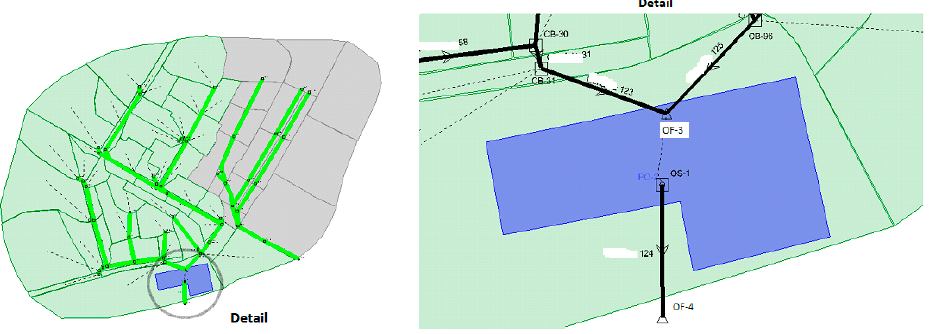
Figure 6. Representation of a retention pond.